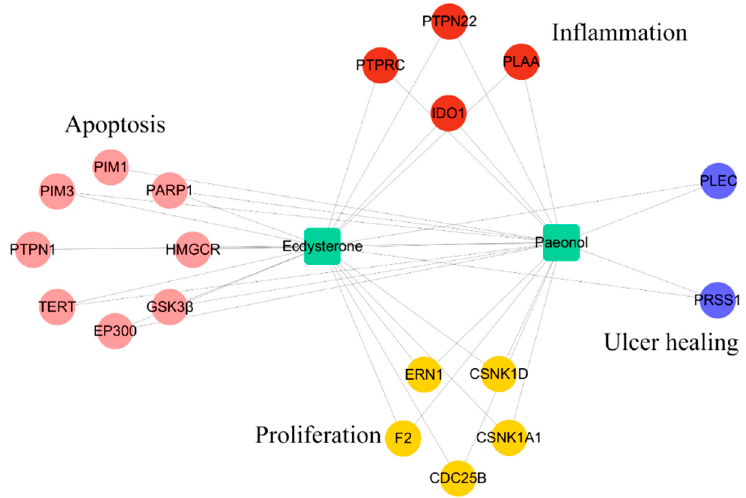
Figure 5. Compound − target (C–T) network constructed by linking Ecdysterone-Paeonol with its potential targets.